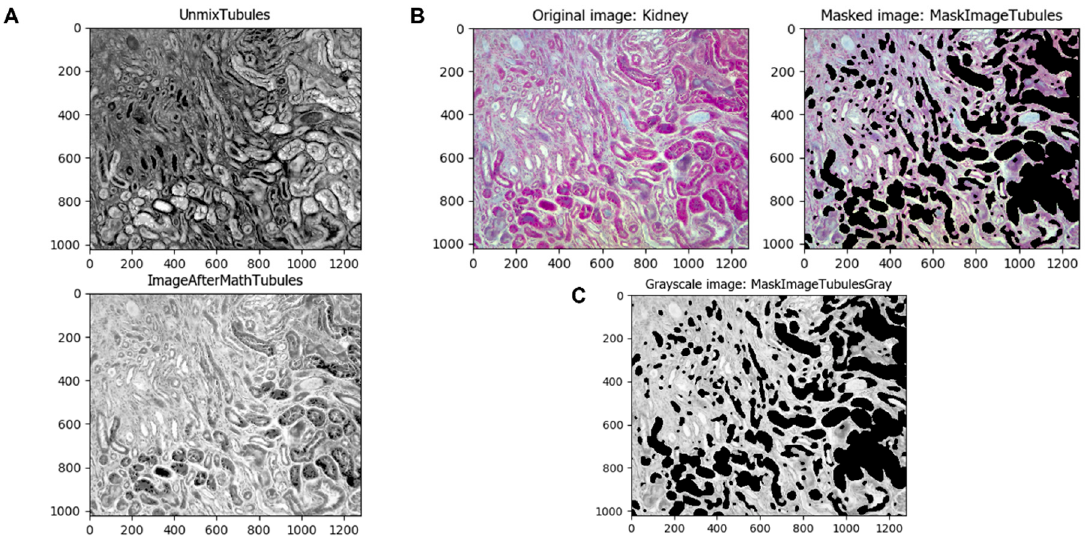
Figure 4. Separation of identified tubules from the original image. ( A ) The ImageMath module can be used to make operations such as inverting the image. ( B ) The MaskImage module masks the original image with the tubule-less image. ( C ) The ColorToGray module changes the color image to a grayscale one.